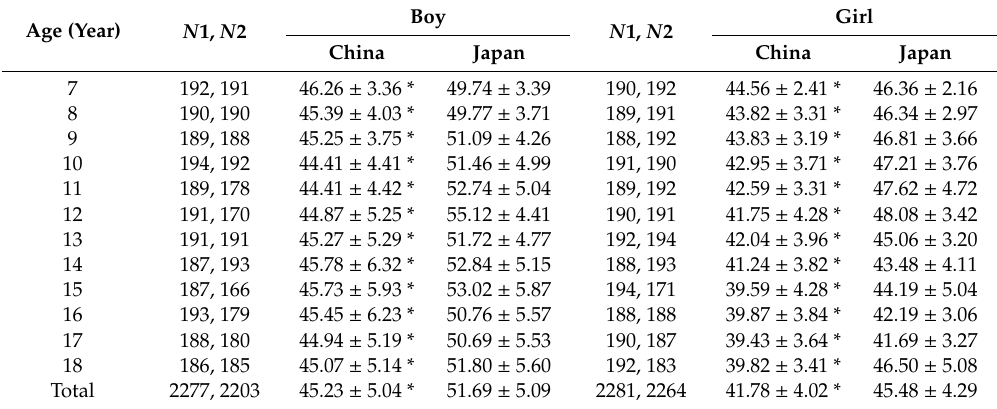
Table 3. Di ff erences in estimated maximal oxygen consumption (VO 2max ) performance between Chinese and Japanese children and adolescents (mL / kg / min).